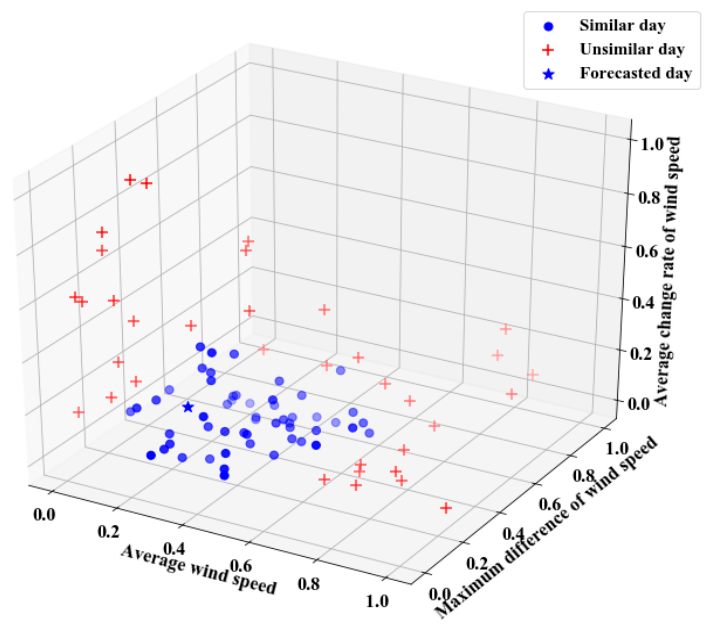
Figure 6. The scatter diagram of the historical days and the forecasted day in three dimensions.